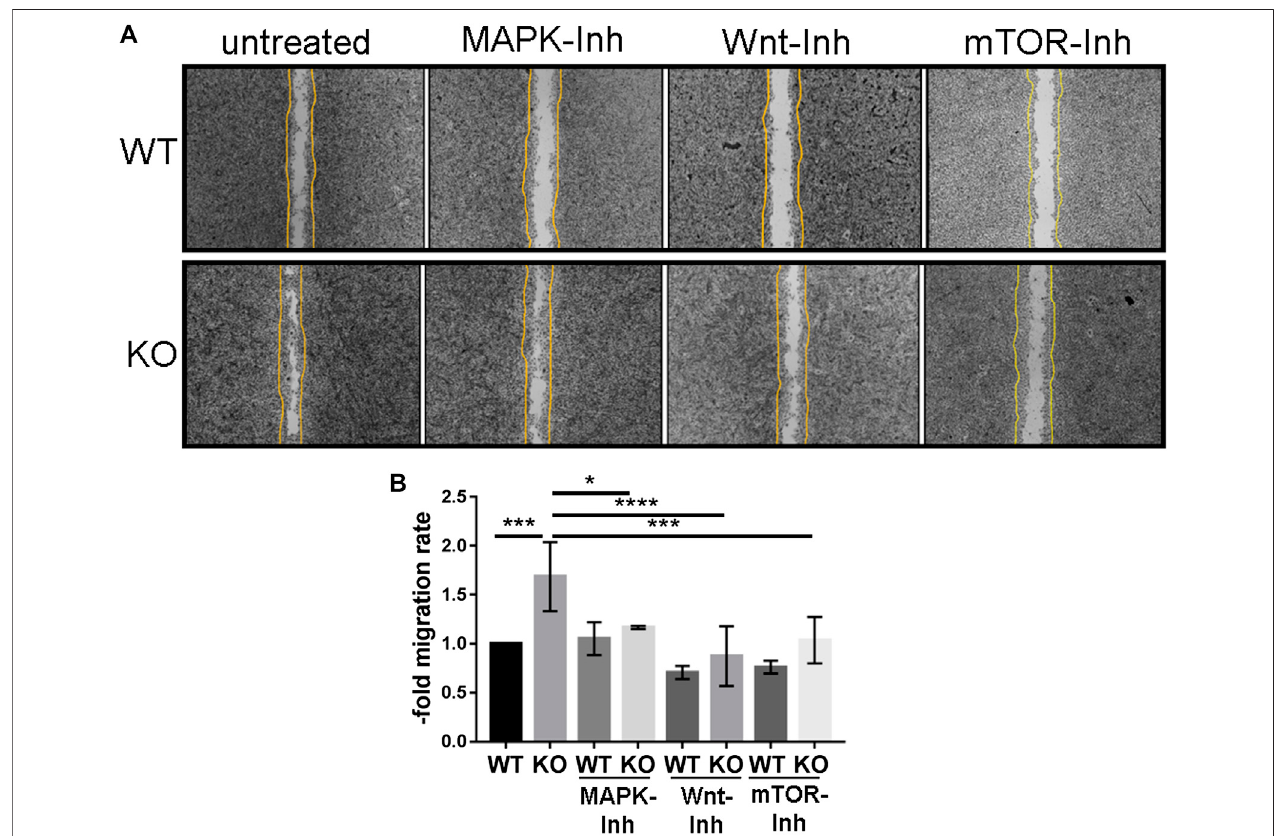
FIGURE5| PcdhgC3knockoutBrainMicrovascularEndothelialCellsmigratefasterinwoundhealingassayandtheirmigrationcanbeinhibitedbyspeci fi cMAPK-, β -catenin/Wnt- and mTOR-signaling pathway inhibitors. Wild type (WT) and PcdhgC3 knockout (KO) BMECs were seeded on µ-Dish and were grown to con fl uence. After24 hserumstarvation,thecellswereleftuntreatedorweretreatedwithMAPK-(SL327,Mek1/2inhibitor,200 nM),Wnt-(XAV939,selective β -catenin/Wntpathway inhibitor, 20 µM), mTOR- (Torin 2, mTOR-inhibitor, 25 nM) signaling pathways inhibitors (MAPK-Inh, Wnt-Inh, mTOR-Inh). The wells separating the cells were removed and the dishes were photographed at time 0 h. The cells were allowed to grow for 48 h into a 500-µm-space and were photographed again at 48 h. (A) The difference in area covered between 0 and 48 h was calculated and a migration rate was normalized to the control, which was arbitrarily set as 1. (B) Data are shown as mean ± standard deviation of three independent experiments. * p < 0.05, ** p < 0.01.